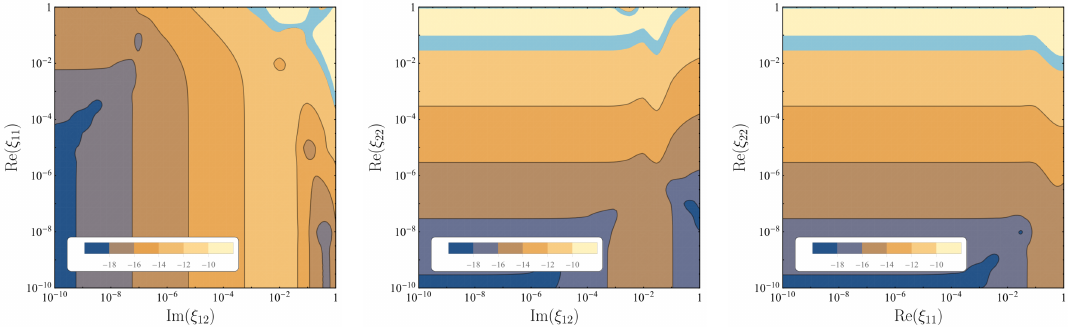
Figure 7 . The density plots of the lepton asymmetry in the (Im ξ 12 , Re ξ 11 ) , (Im ξ 12 , Re ξ 22 ) and (Re ξ Re ξ ) planes with the parameterization (4.21). The normal mass hierarchy and real CI 11 , 22 parameters are adopted for realizing Y ( ∞ ) ∼ 10 − 10 . ∆ L